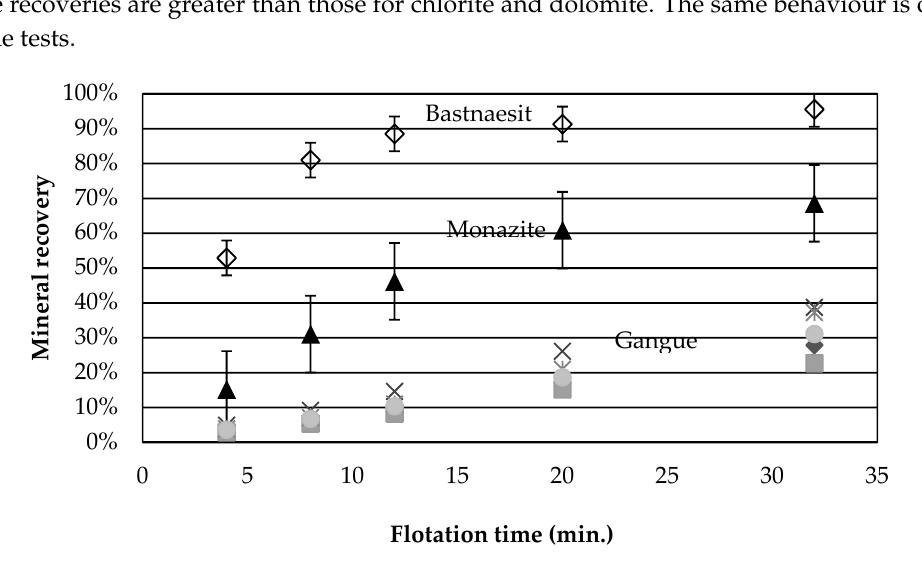
( a ) ( b ) Figure 3. Mineral recovery as a function of time for experiment 4 (75 °C, 2400 g/t Na 2 SiO 3 , 0 g/t guar gum). ( a ) Overall; ( b ) Close-up on gangue minerals. Although these results reveal information about the behaviour of minerals in the various tests, comparative analysis remains tedious. Grade-recovery curves are proposed as simple and rapid tools